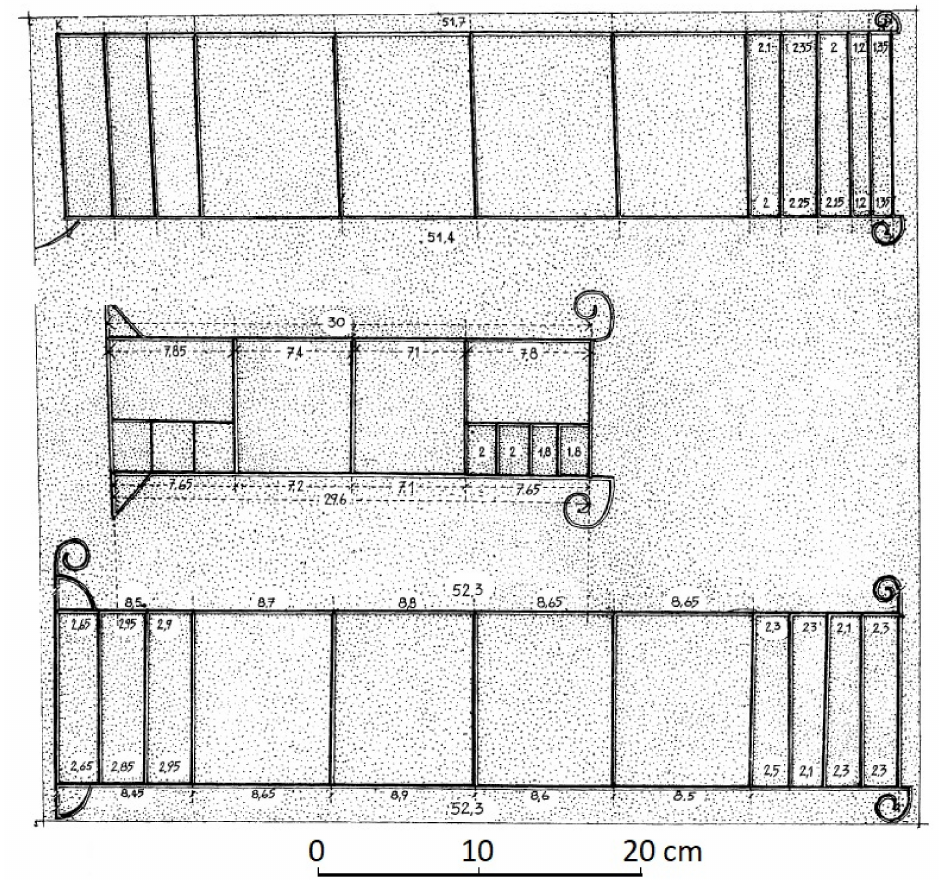
Figure 1. A relief from Leptis Magna, Libya, showing three ancient metrological units and their divisions, and permitting their comparison. Top: Punic cubit, 514–517 mm. Middle: Roman foot, 296–300 mm. Bottom: Egyptian royal cubit, 523 mm. Millimeter-scale differences in the length of units and of their subdivisions, marked on the relief indicate the accuracy of the ancient measuring systems. From